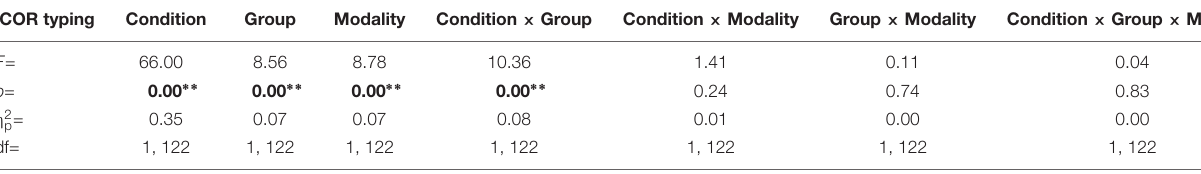
TABLE 6 | ANOVA results for correctness (COR) of the typing task.